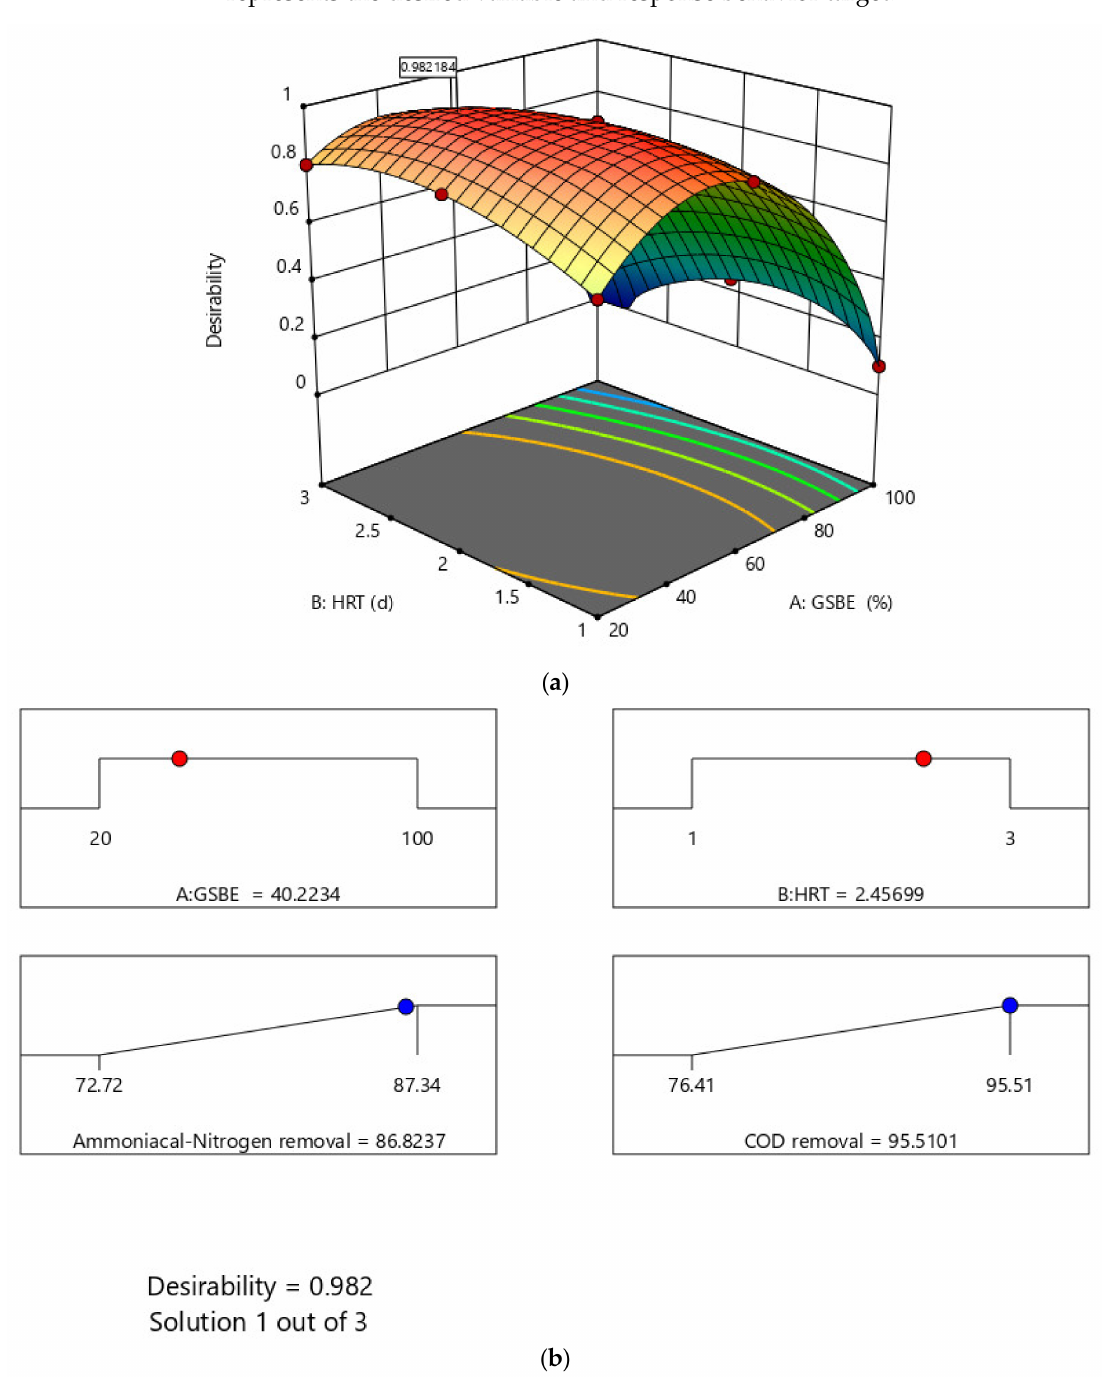
Figure 10. ( a ) Numerical ramps for response optimization and ( b ) desirability plot for the bioreactor